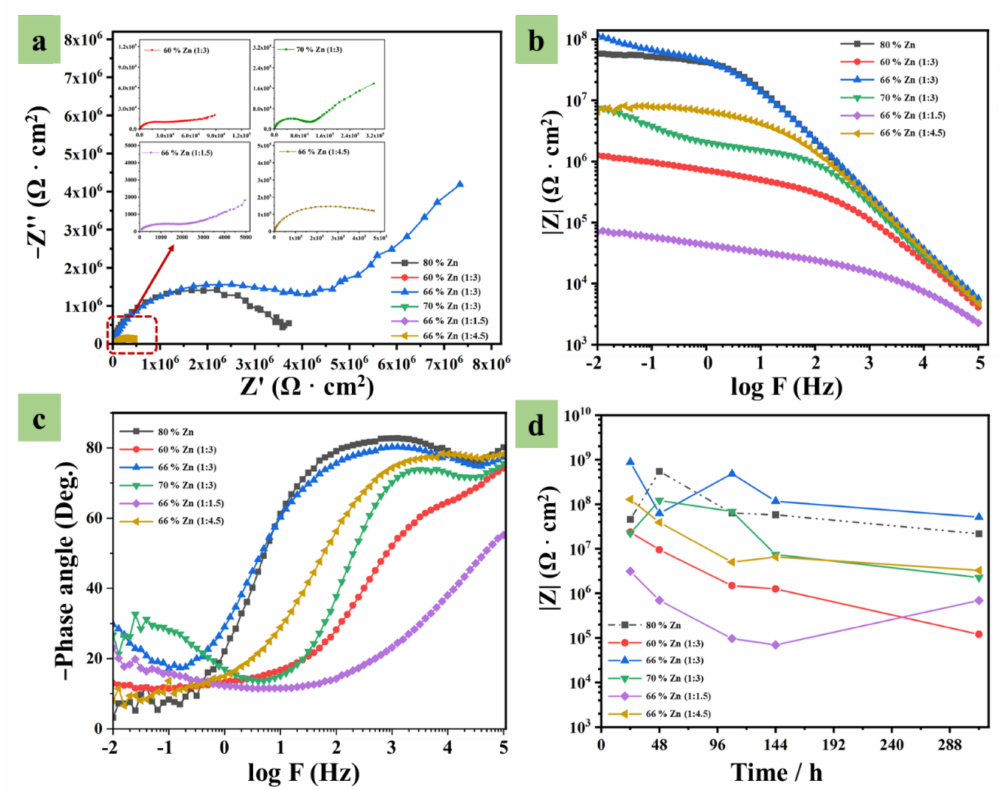
Figure 11. Nyquist plot ( a ), Bode plot of impedance ( b ) and Bode plot of phase angle ( c ) of ZRP coatings in 3.5 wt % NaCl aqueous solution after 144 h; the relation between time and impedance at